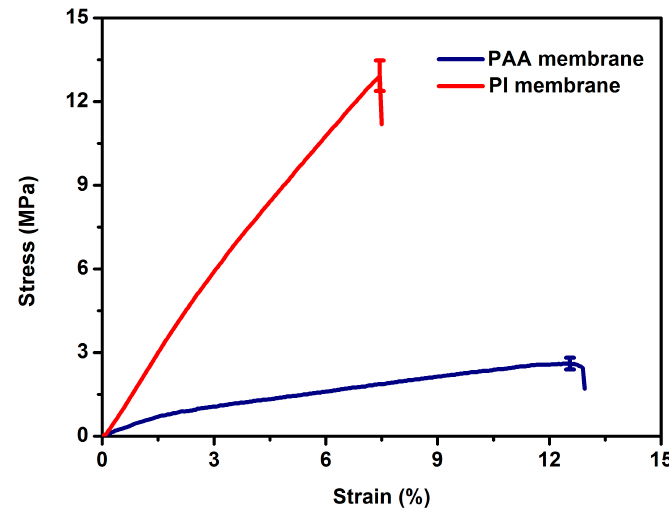
Figure 9. Tensile stress-strain curves of PAA and PI nanofiber membranes.